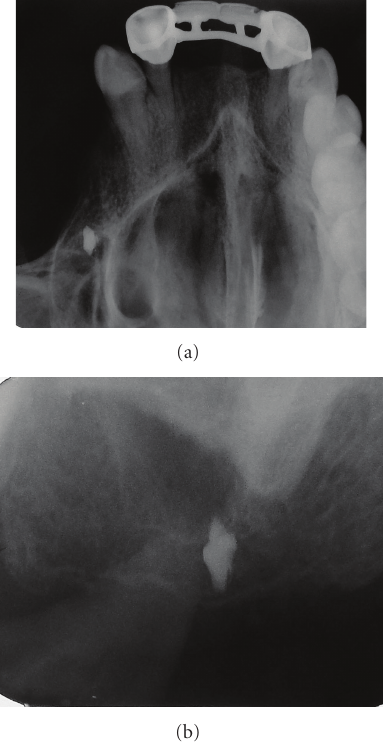
Figure 2: (a) Maxillary occlusal X-ray. (b) Periapical X-ray. Notice the closure of the foreign body to the right maxillary sinus, and also a nonhealed 3 alveolus.